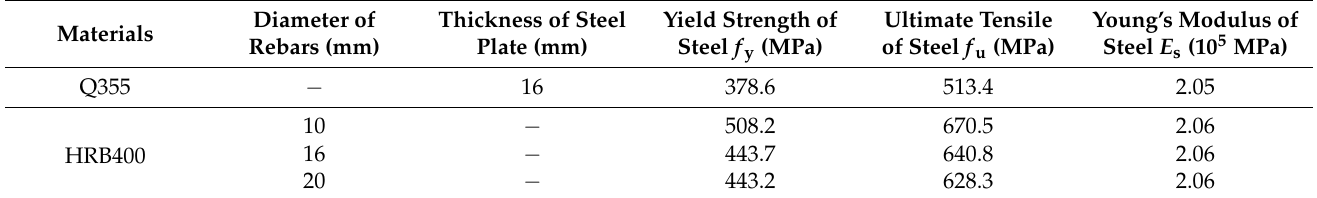
Table 3. Material properties of steel.